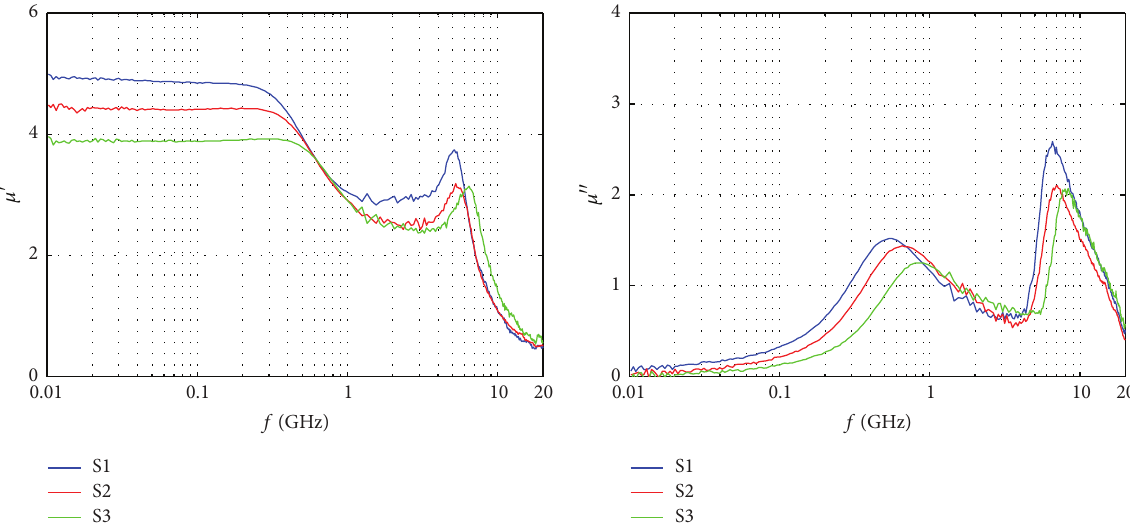
Figure 4: Complex permeability spectra of the sintered ferrite samples.